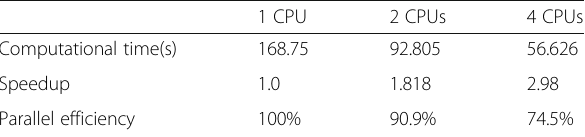
Table 5 Computational time, speedup, and parallel efficiency for airfoil